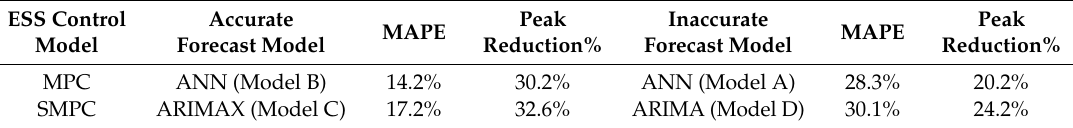
Table 1. The average peak demand reduction and the mean absolute percentage error (MAPE)